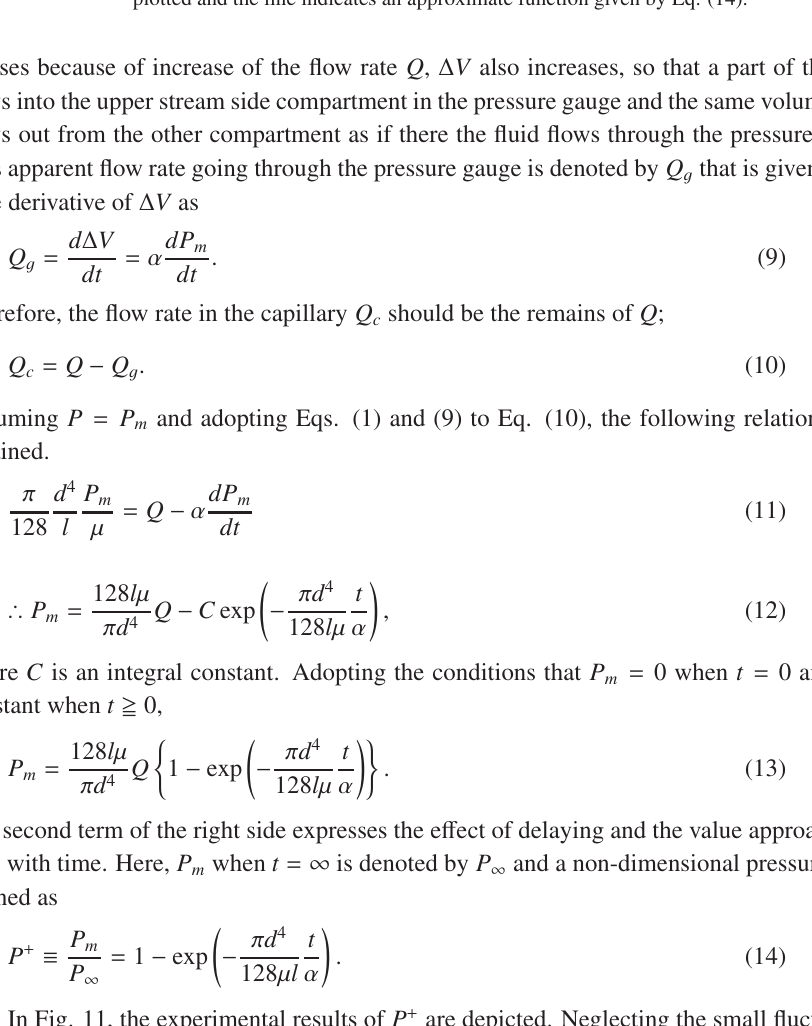
Fig. 11 The time series of the non-dimensional pressure P + . The measured results are plotted and the line indicates an approximate function given by Eq.